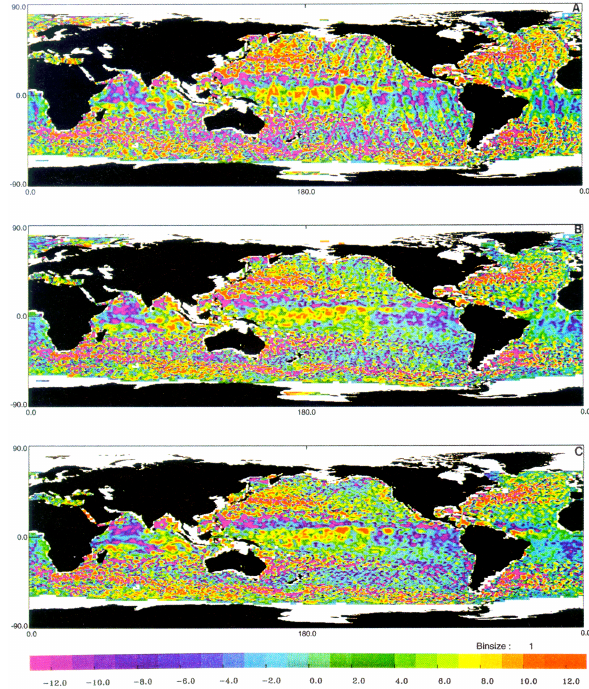
Fig. 5. ERS orbit error reduction using TOPEX/Poseidon as a ref- erence. The impact of the correction is shown on a map of sea level anomaly derived from ERS observations at a given day without (up- per figure) and with (middle figure) the correction. This can be com- pared to the map derived from TOPEX/Poseidon observations (bot- tom figure). (from Le Traon and Ogor, 1998). Units are